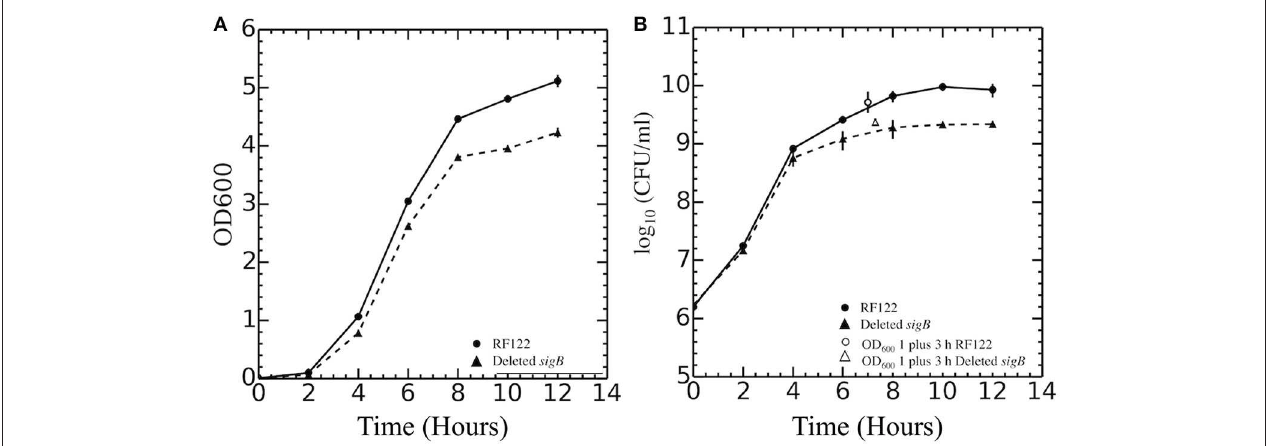
FIGURE 1 | Growth curves of Staphylococcus aureus RF122 and 1 sigB mutant strains. (A) Relationship between OD 600 of each strain and time of incubation. (B) Relationship between log 10 colony-forming units (CFU) per milliliter of each strain and time of incubation. The experiment was performed in three biological replicates.